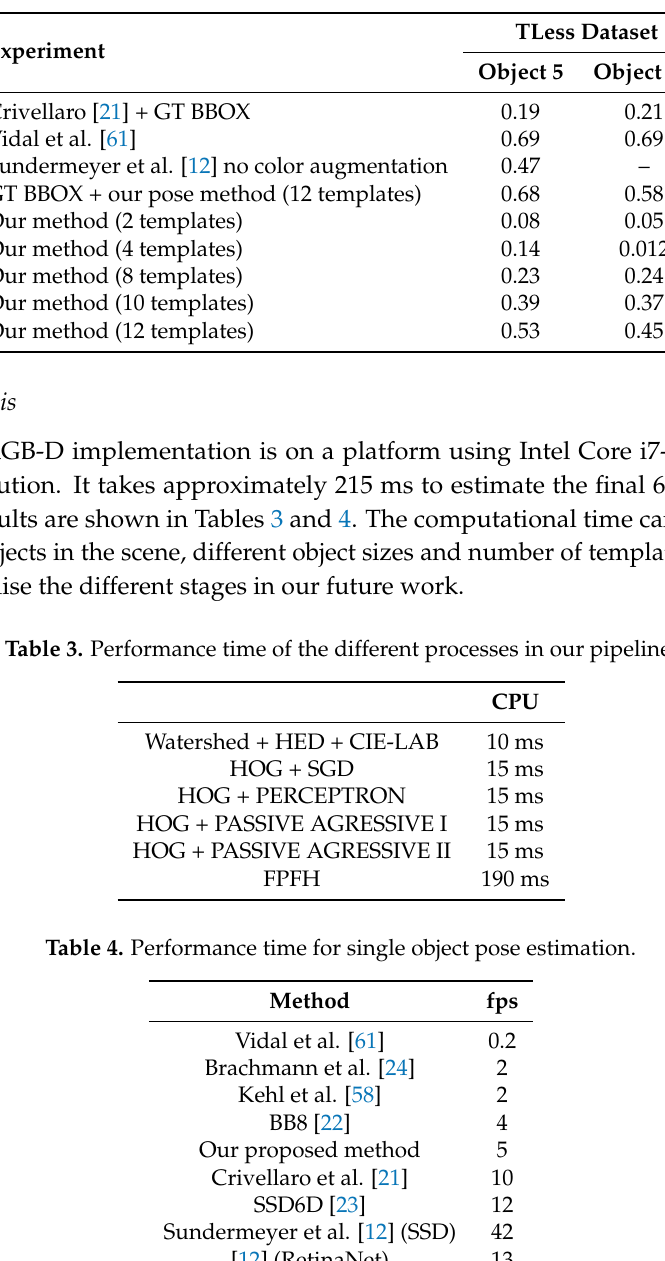
Table 2. Pose Estimation Results on TLess Dataset- (Object 5 and Object 11).